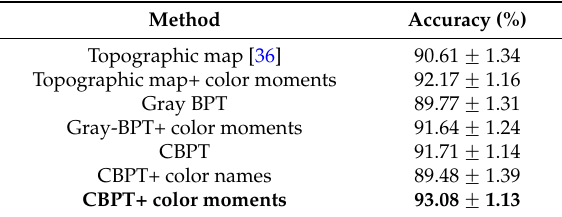
Table 3. Comparison of different color features on BPT.